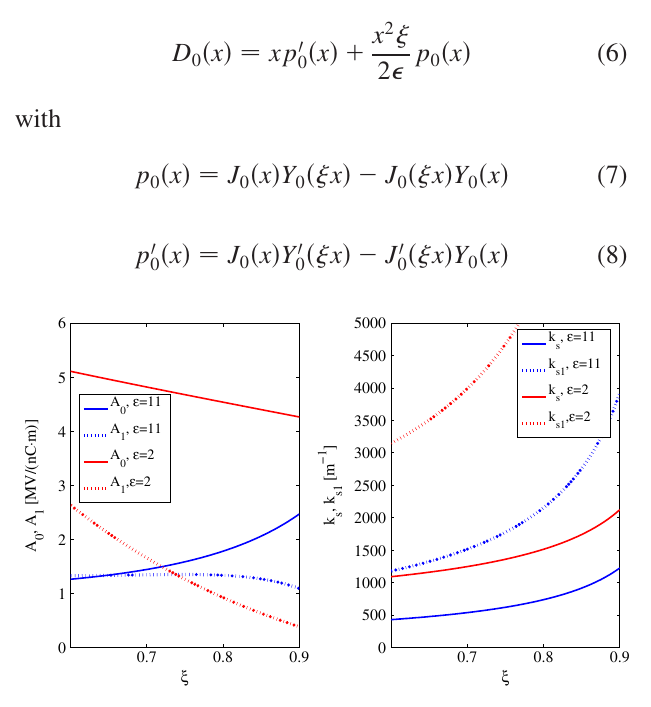
FIG. 2. (Color) Amplitudes ( A and k s ) as a function of the parameter (cid:3) ¼ r 1 3 mm